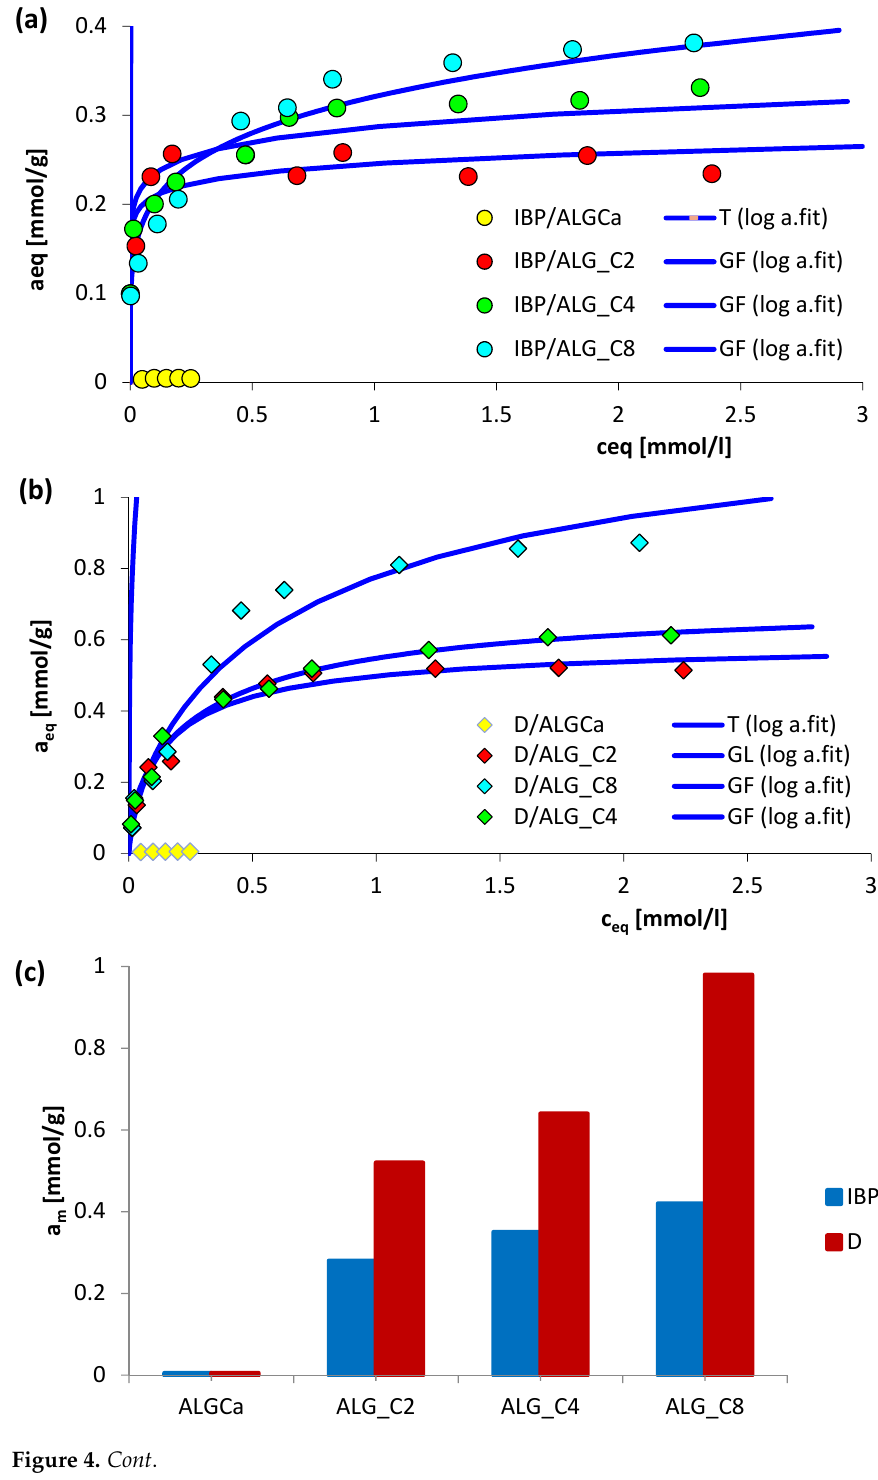
ALG_C8 [magnifications: 50—( e ), 500—( f ), 1000—( g ), 5000—( h ) and C (magnifications: 100—( i ),